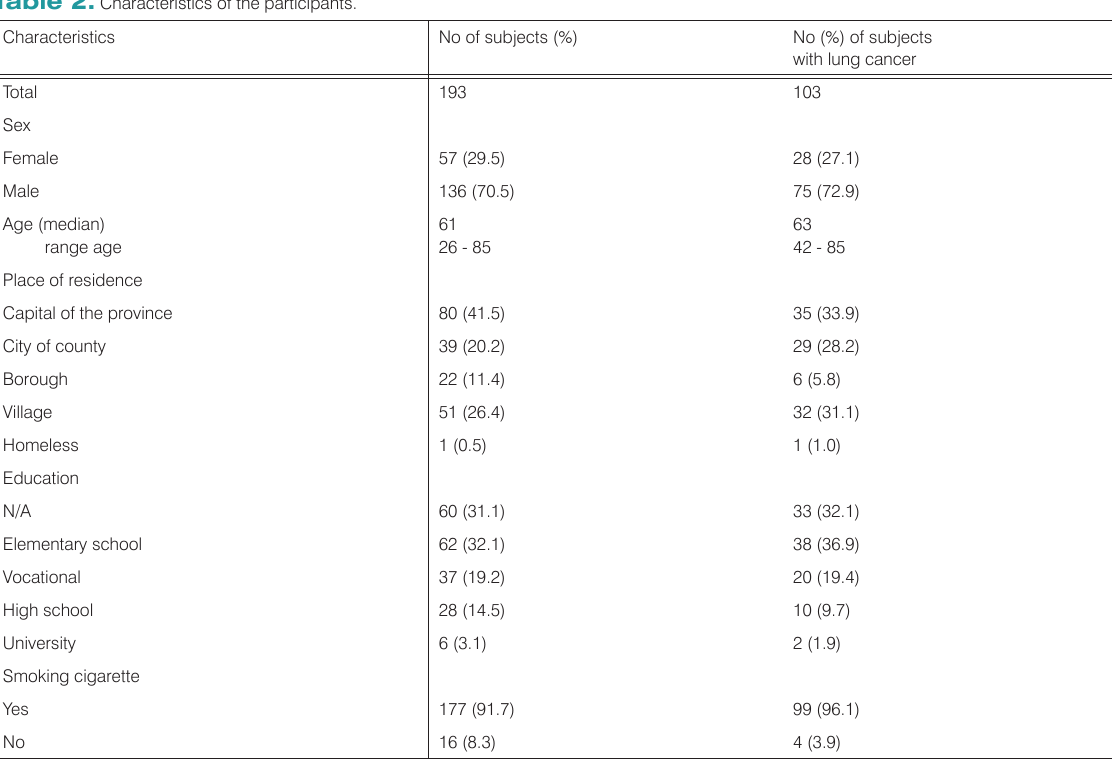
Table 2. Characteristics of the